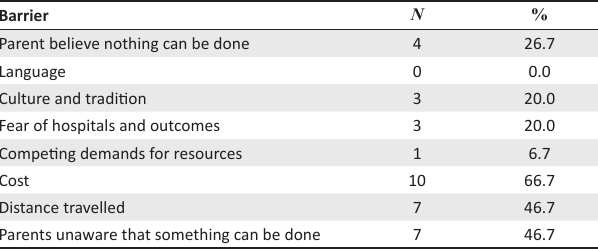
TABLE 3: Eye health practitioners who reported barriers to accessing eye care services by children.